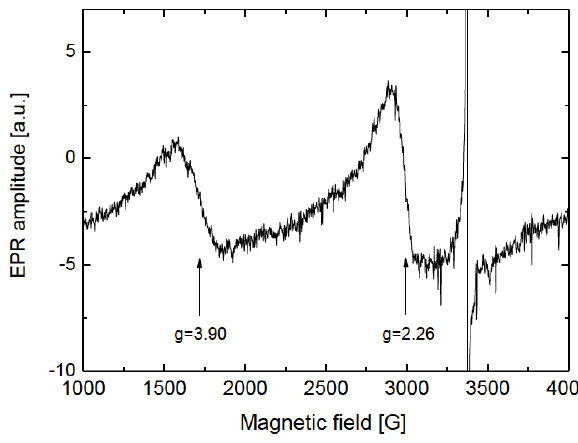
Figure 18: EPR spectrum of BLF components at RT in B-550 sample.